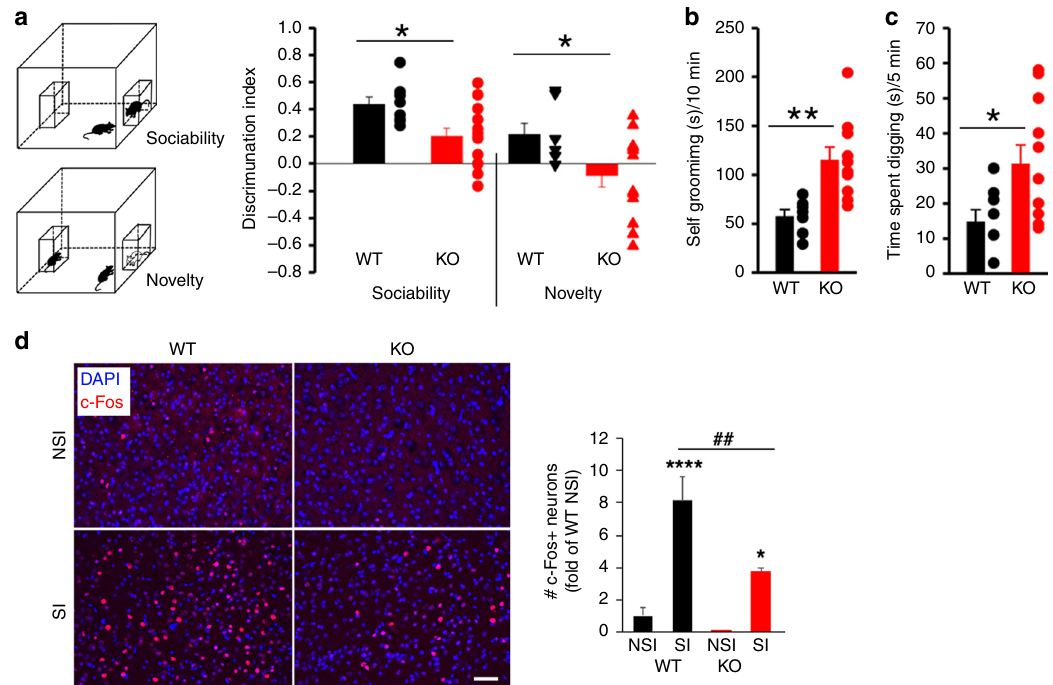
Fig. 1 PV- Lmo4 KO mice display autism-like behaviors. a KO mice have reduced social interaction. The sociability discriminative index compares the time spent in the interaction zone when a littermate is present or absent. The novelty index compares the interaction with a “ stranger ” to the interaction with a familiar littermate. n = 8 WT, 14 KO mice. b KO mice show increased self-grooming ( n = 7 WT, 10 KO) and c digging compared to littermate controls ( n = 8 WT, 11 KO). d c-Fos staining revealed neuronal activation in L2/3 of ACC in mice 30 min after social interaction. NSI, no social interaction; SI, social interaction. c-Fos + neuron numbers were counted and normalized to WT NSI. * and **** are SI compared to NSI for each genotype. n = 4 mice per genotype per condition. Scale bar, 50 μ m. All data are presented as means ± SEM. *, **, ##, ****, p < 0.05, 0.01, 0.01, 0.0001,